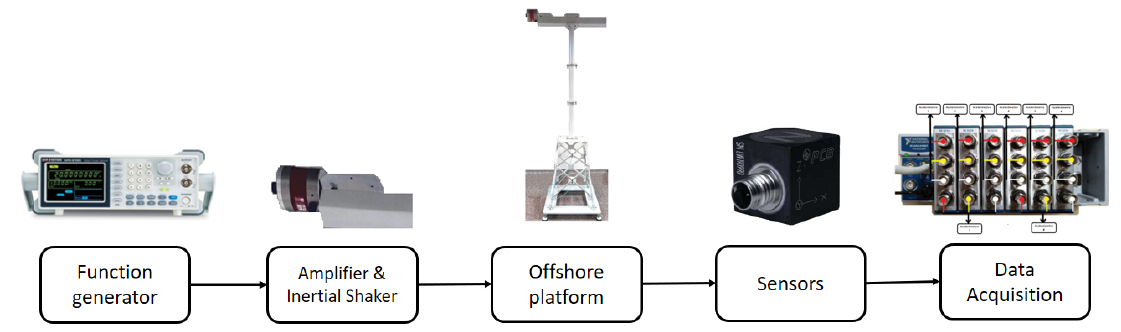
Figure 2. General overview of the experimental